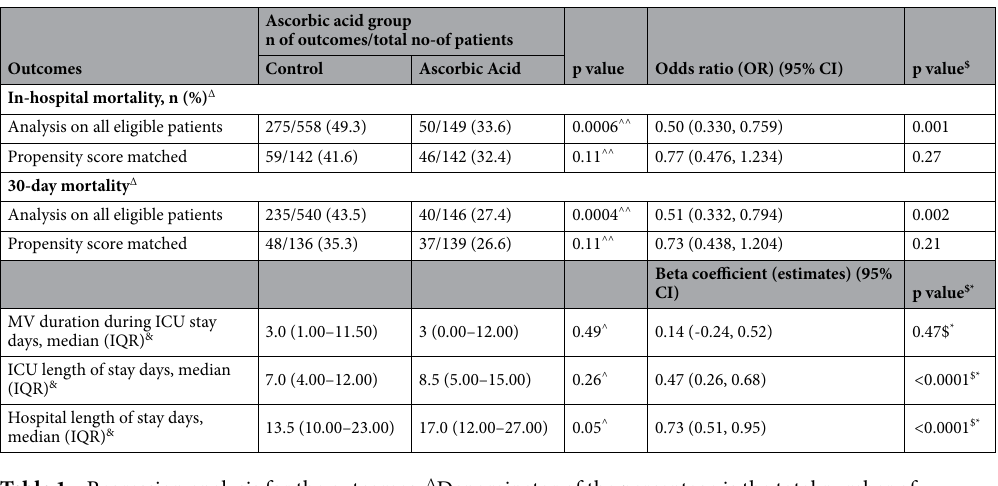
Table 1. Regression analysis for the outcomes. ∆ Denominator of the percentage is the total number of patients. & Denominator is patients who survived. ^Wilcoxon rank sum test is used to calculate the p value. ^^Chi-square test is used to calculate the p value. $ *Propensity score adjusted Generalized linear model is used to calculate estimates and p value. $ Propensity score adjusted Logistic regression is used to calculate Odds ratio and p